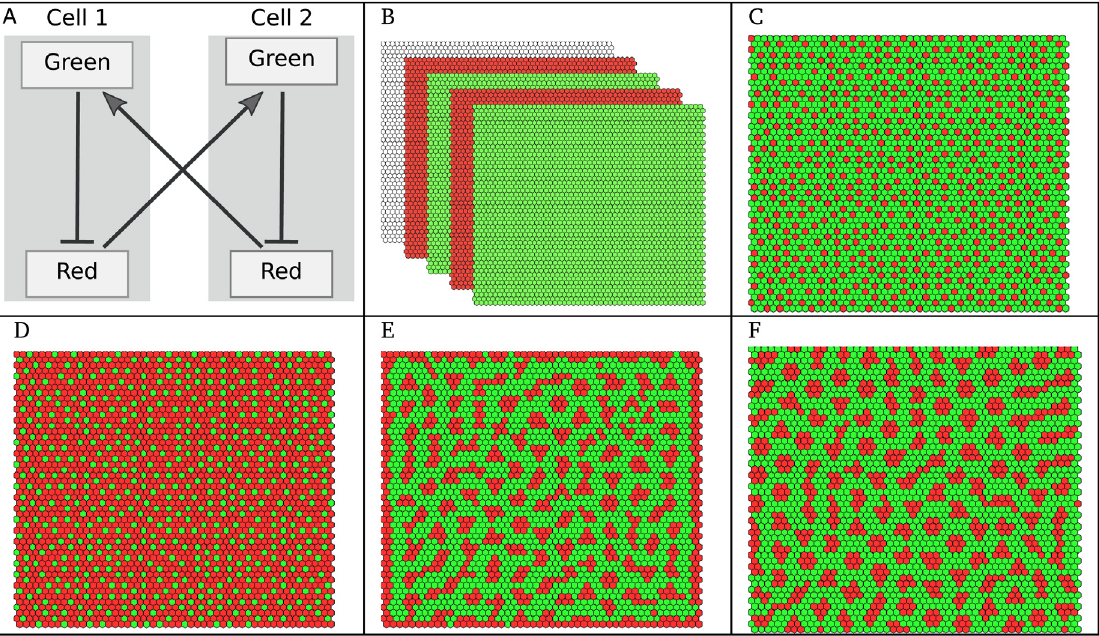
Figure 1. ( A ) An idealised Boolean model of lateral inhibition; the Green marker is induced by the Red marker secreted by the neighbouring cell, whereas Red is induced by low levels of Green in the same cell (normal arrows denote activations, whereas blunt arrows denote inhibitions); the synchronous dynamics of this two cell model leads to a cyclic attractor (see Supplementary File 1). ( B ) Simulation in EpiLog, with the same cellular model over a square grid of 50×50 hexagonal cells under a synchronous update (Green induced if at least one contacting cell is Red), oscillations are due to the synchronous update of the cells, see Supplementary Movie 1. ( C – F ) Simulations under α -asynchrony ( α = 0.25): ( C ) Stable state of the grid, referred to as “stable pattern”, reached in 29 steps (Green induced if at least one contacting cell is Red), see Supplementary Movie 2; ( D ) Stable reverted pattern reached in 30 steps (Green induced if all contacting cells are Red); ( E ) Stable pattern reached in 63 steps (Green induced if at least 12 cells at distance up to 3 are Red); ( F ) Stable pattern reached in 70 steps, with the same setting as for panel E but considering a torus ( i.e. , no grid